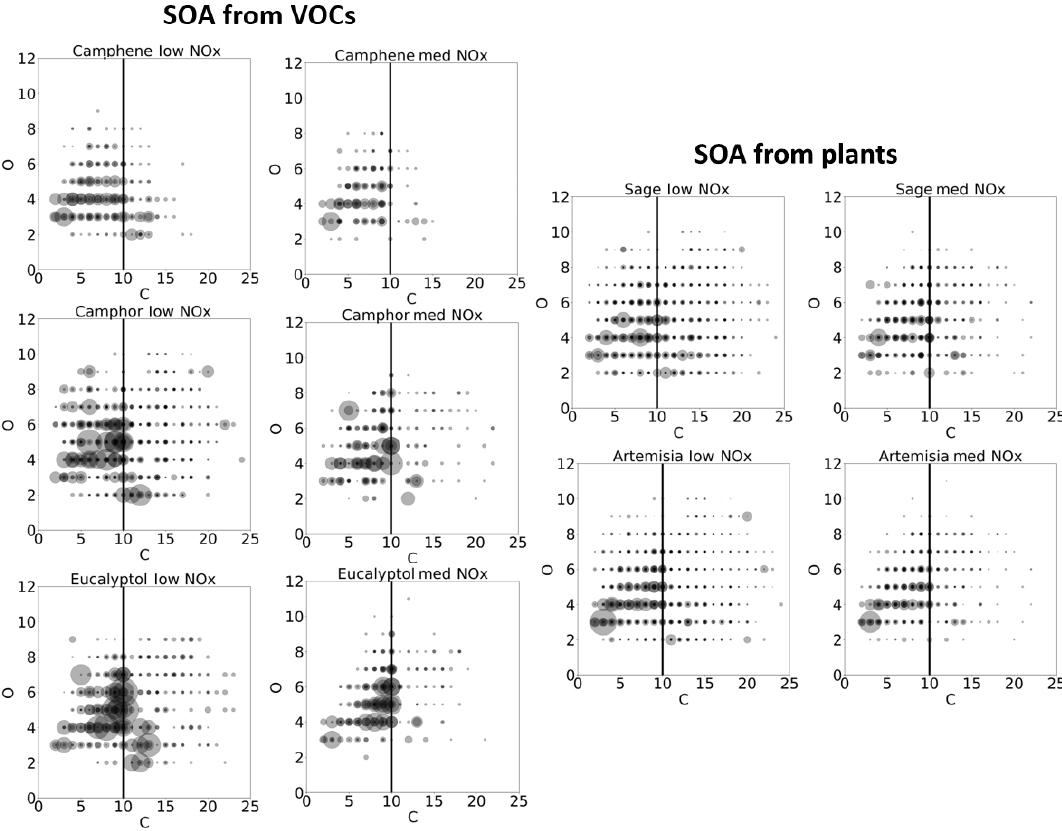
Figure 4. Carbon vs. oxygen plot for aerosol-phase composition under low- and medium-NO x conditions for volatile organic compound precursors and plants. (The vertical black line separates monomers and oligomers in carbon-number space, and the symbols are proportional to the ion intensity.) Table 3. Bulk composition of secondary organic aerosol from single-component standards and